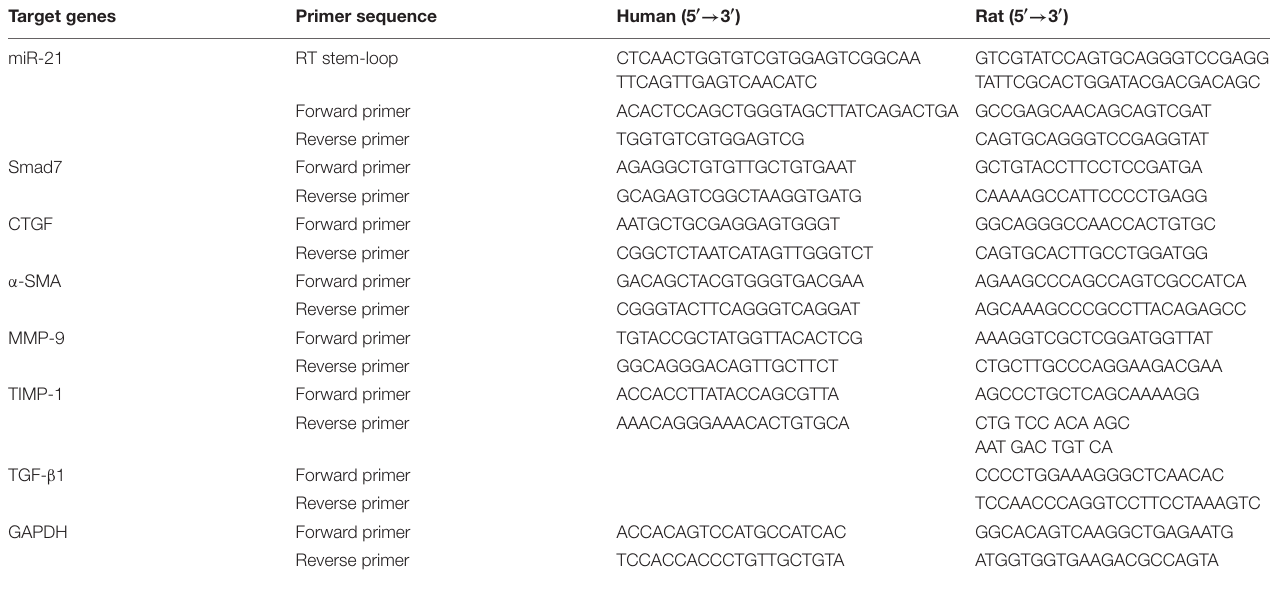
TABLE 1 | Primer sequences for Real-time